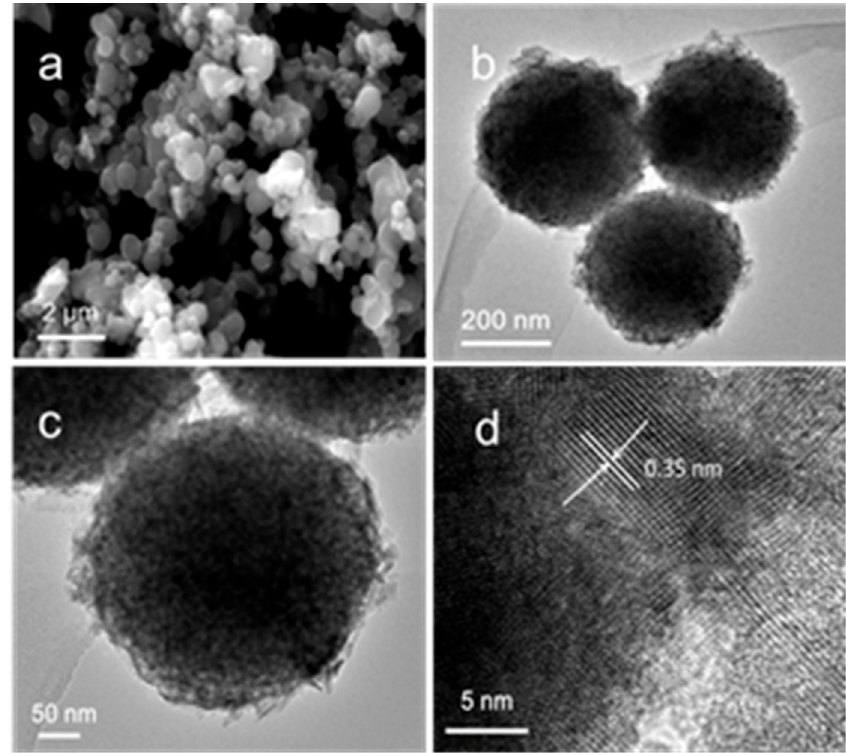
Figure 3. ( a ) Typical SEM, ( b , c ) show TEM images of MTiO 2 /Ala-DDA with different magnifications, and ( d ) shows the HTEM for MTiO 2 /Ala-DDA nanocrystallinity.